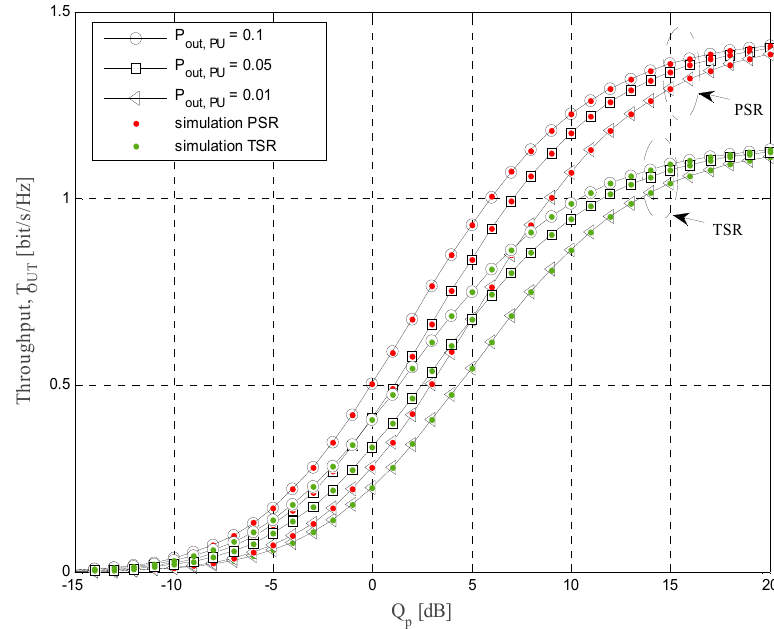
Figure 8. The achievable throughput vs. interference threshold Q p .